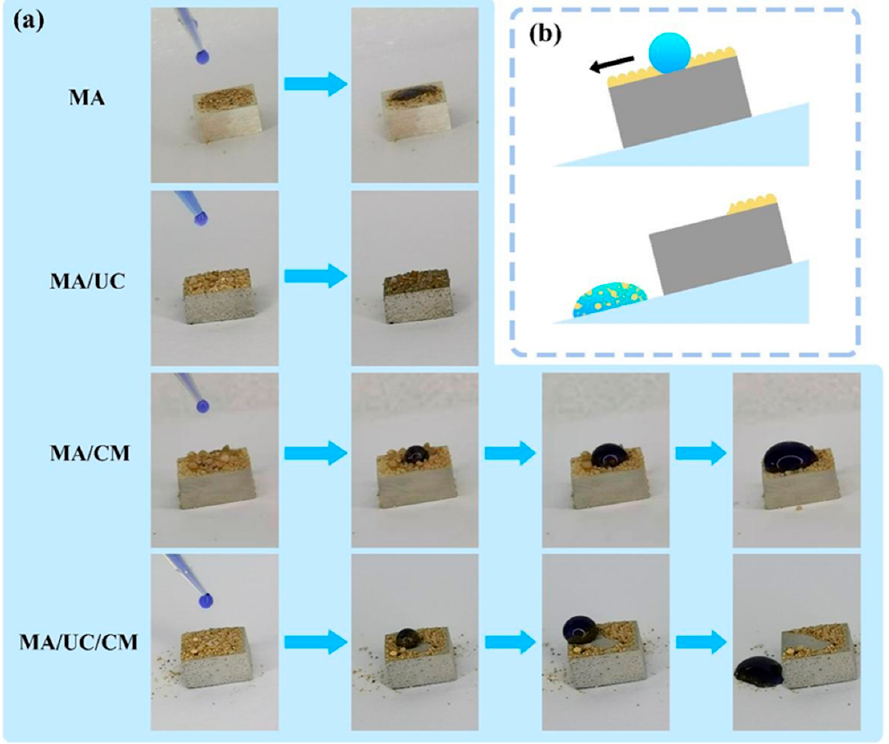
Figure 7. ( a ) Self-cleaning behavior of all the investigated samples; ( b ) schematic diagram of the test.